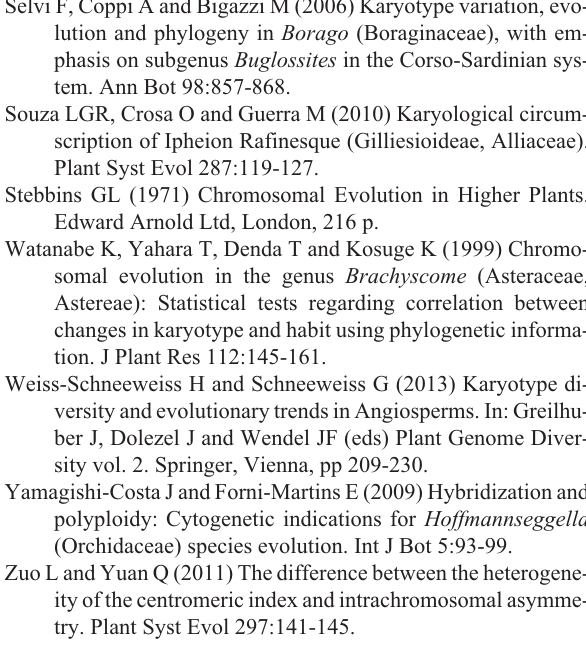
Figure S1 - UPGMA analysis using the intrachromosomal asymmetry values from TF% index. Figure S2 - UPGMA analysis using the intrachromosomal asymmetry values from Ask% and A indexes. 1 Figure S3 - UPGMA analysis using the intrachromosomal asymmetry values from Syi and A